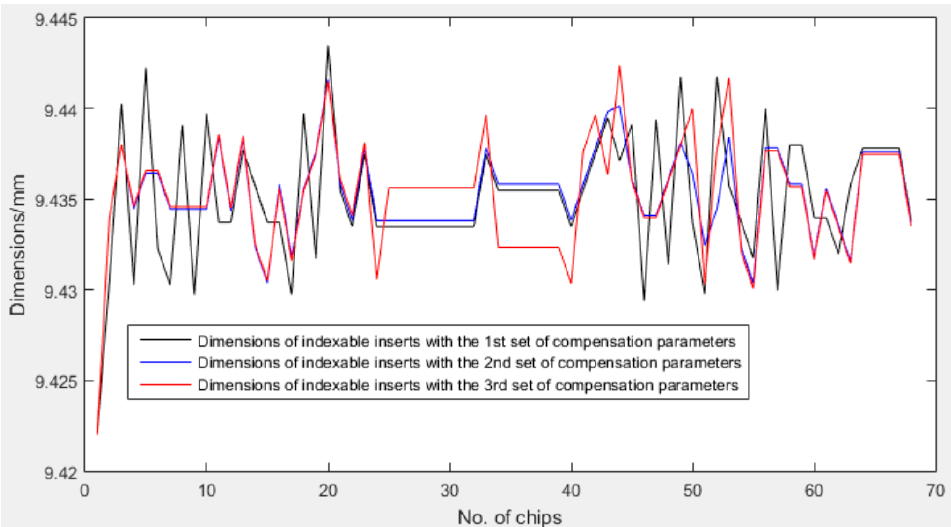
Figure 10. Dimensional variation with three sets of compensation parameters for the compensation experiment. Table 2. Dimensions of the machined workpieces before and after compensation.